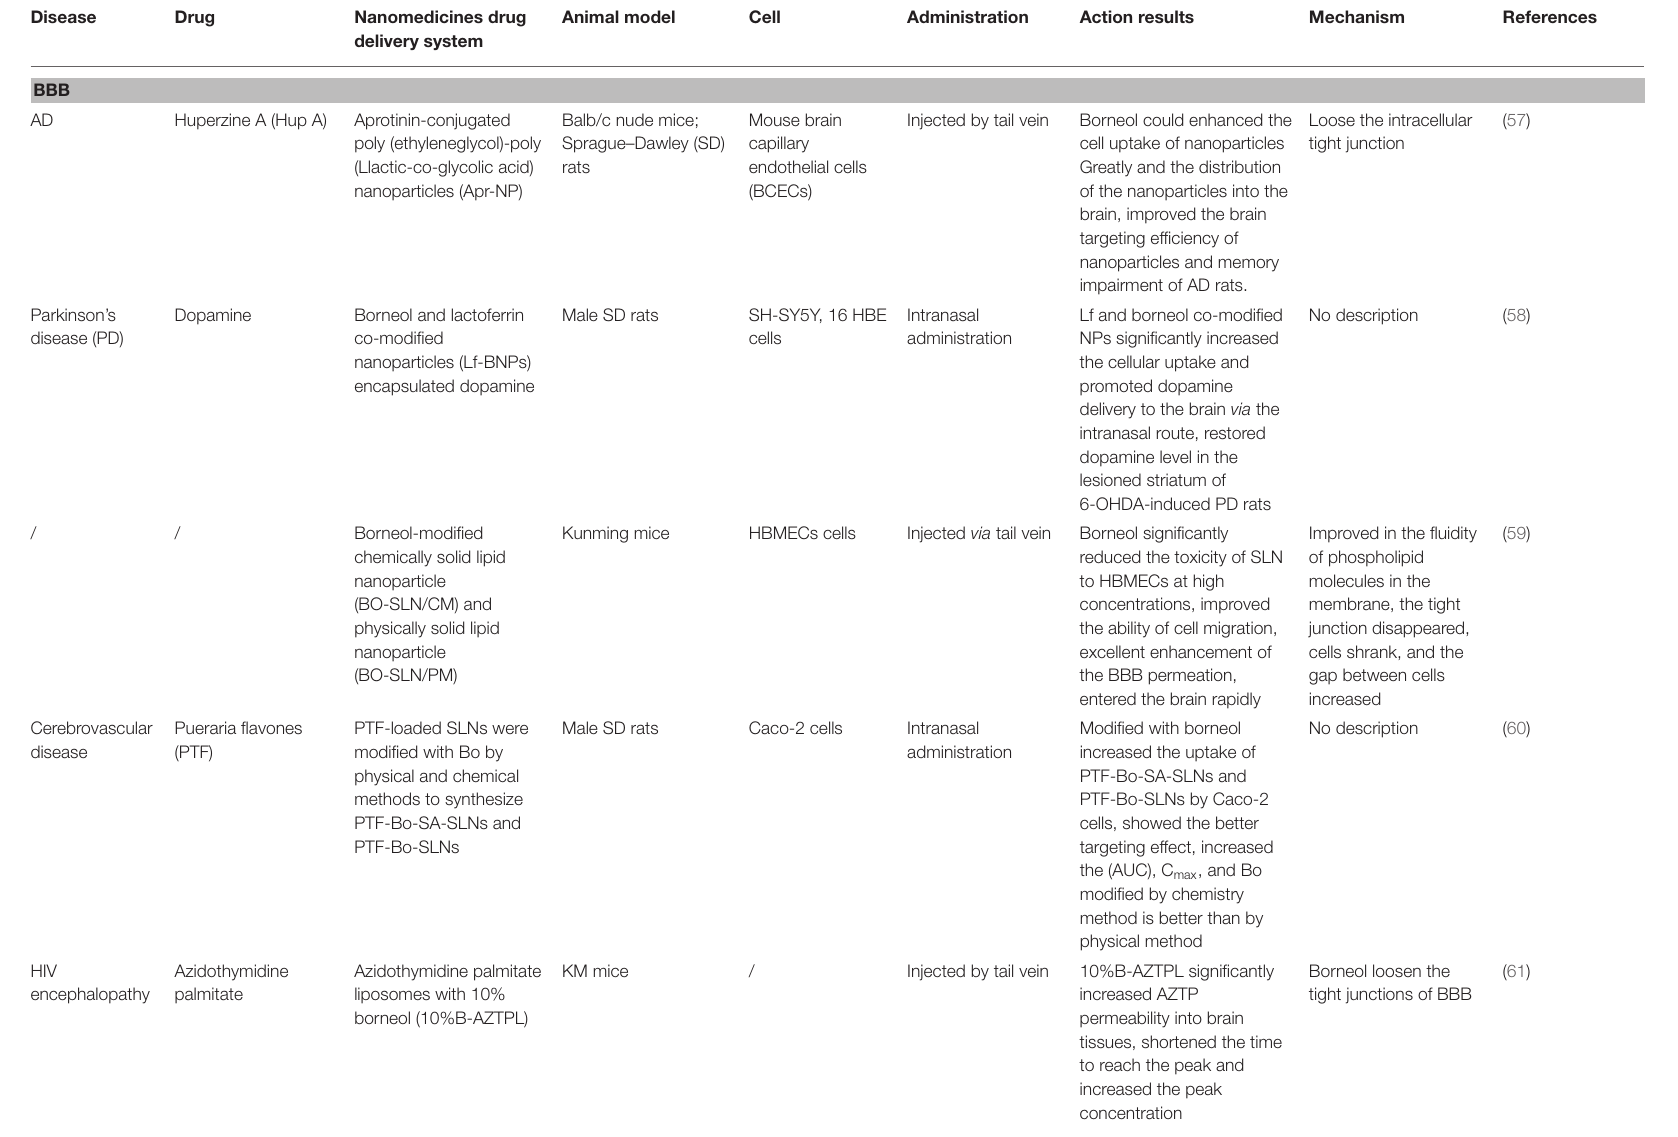
TABLE 2 | Nanomedicine co-modification and co-administration with borneol can enhance drug delivery and absorption to the brain, skin, and gastrointestinal mucosa.